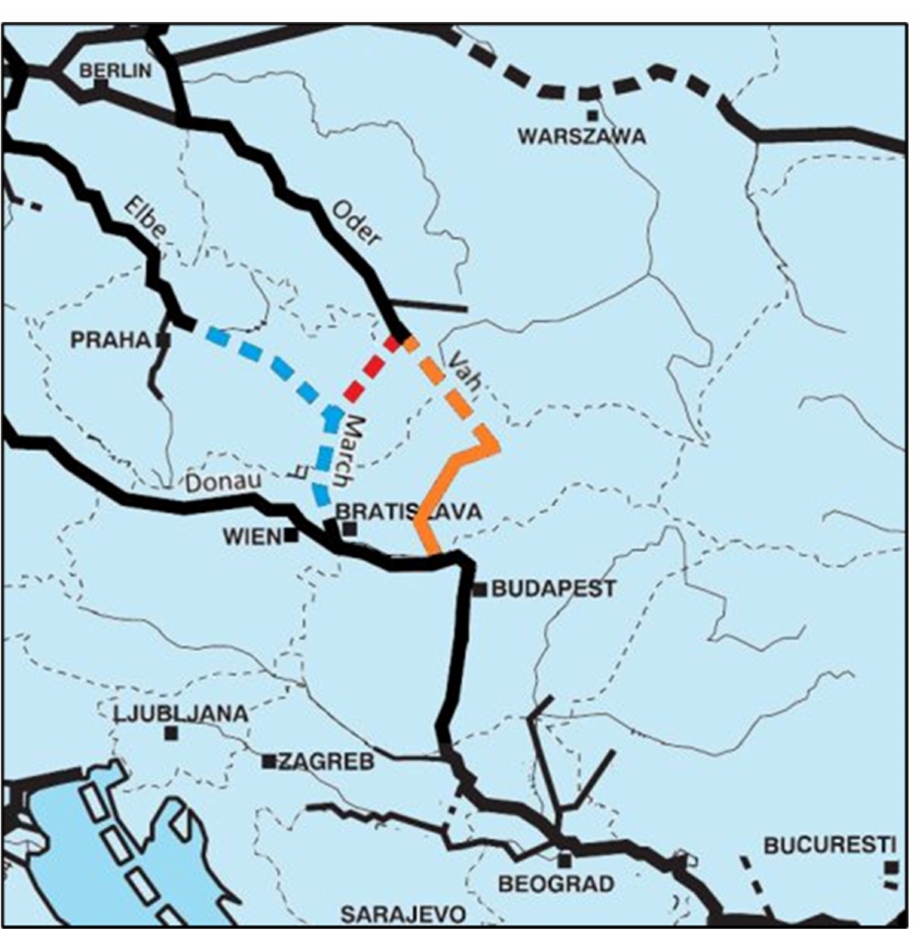
Figure 8. The concept of the Danube–Oder–Elbe Canal, including the V á h River, resulting in a sub- stantial NE extension of the Rhine–Main–Danube corridor. Source: https://meta.eeb.org/2021/02/ 02/controversial-plans-for-destructive-danube-oder-elbe-waterway-moving-forward/ (accessed on 8 January